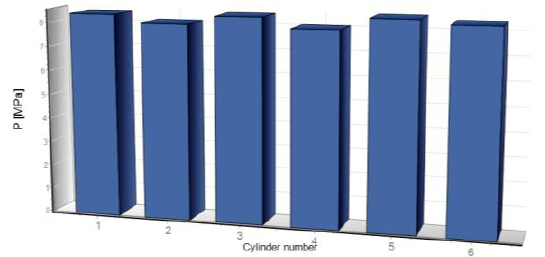
Fig. 6. The values of the maximum indicated pressure for the engine working with the crankshaft rotational speed of 750 rpm and the load